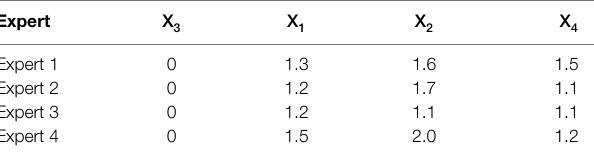
TABLE 5 | Assessment of the importance of indexes–G1 method. Expert